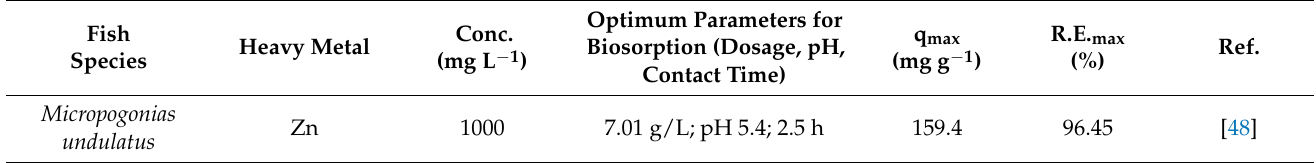
Table 1. Performance of several fish scale types in the removal process of heavy metal ions from synthetic solutions